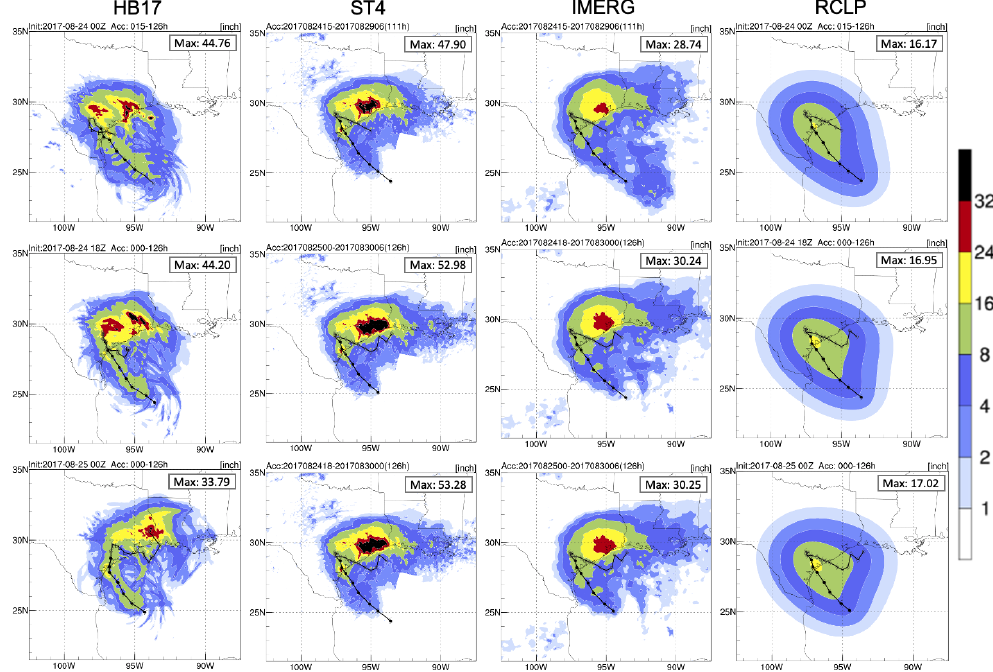
Figure 3. Rain swaths for HB17 (1st column), Stage IV (2nd column), IMERG (3rd column), and R-CLIPER (4th column). The first row represents the model forecast start time at 0000 UTC 24 August 2017, the second row is at 1800 UTC 24 August 2017, and the third row is at 0000 UTC 25 August 2017. Black lines are the forecast/best tracks of models/observations. The markers are 6 hourly storm locations. The maximum values of accumulated rainfall are shown in the top-right corner of each